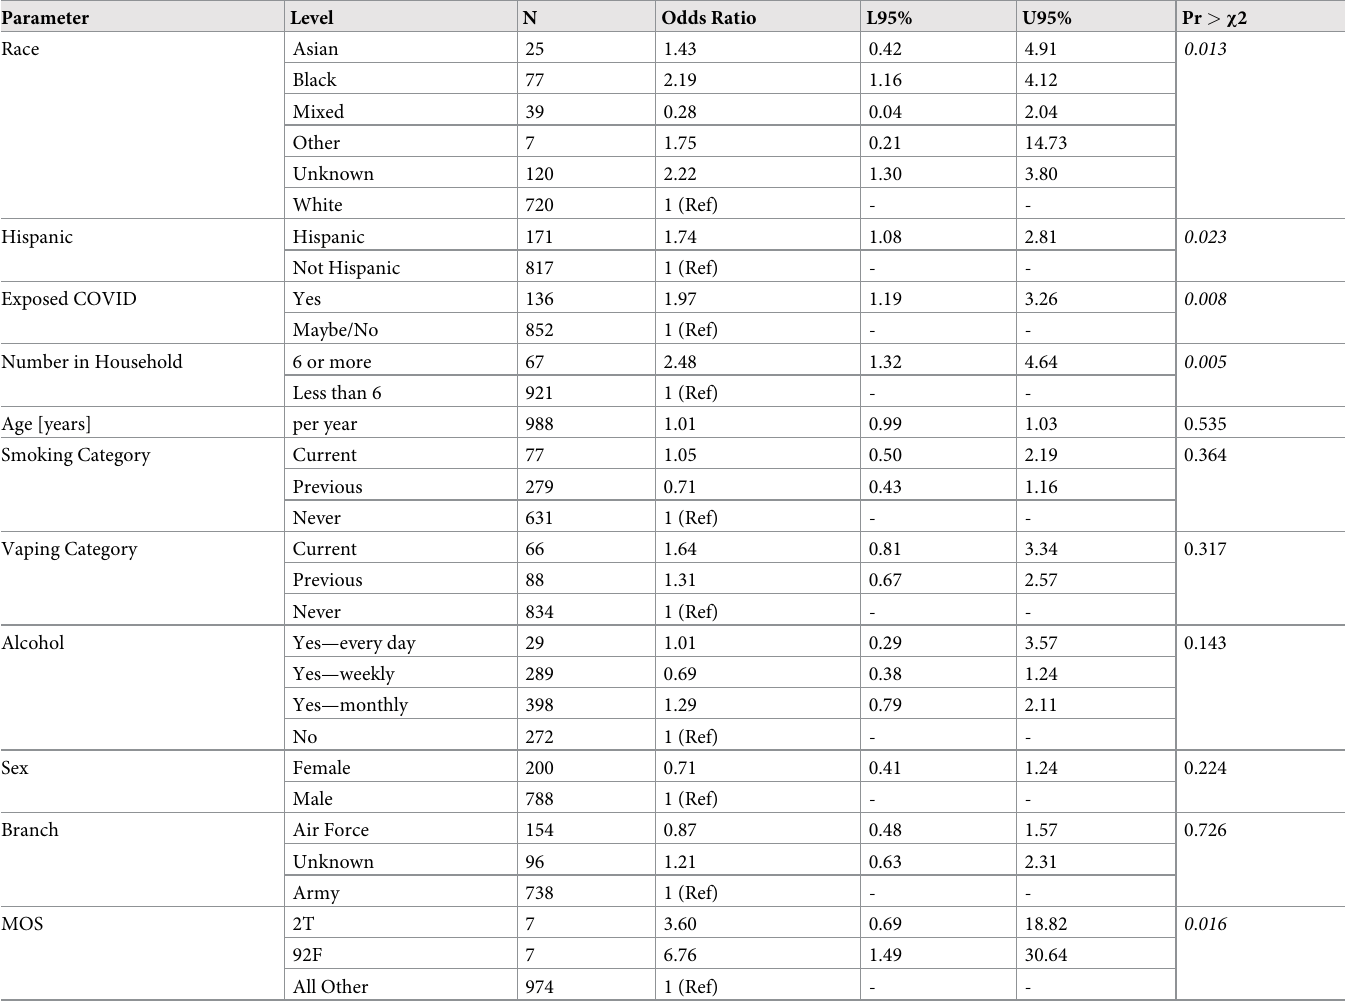
Table 1. Demographic/occupational data: Associations with SARS-CoV-2